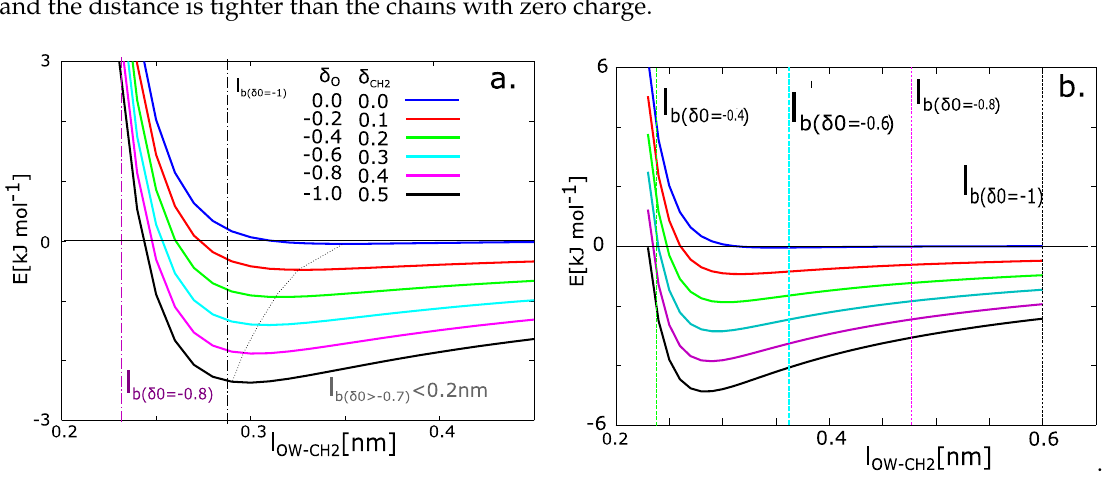
Figure 6. Potential function of the attraction of water to the macromolecular chains as a function of the distance of water from the macromolecular chain and partial charge ( δ ) on a CH 2 group. ( a ) Results for macroscopic relative permittivity of water ( ε r = 80); ( b ) results for relative permittivity of water on molecular level ( ε r = 40); The potential energy is the sum of Lennard-Jones potential and electrostatic potential; l b — Bjerrum